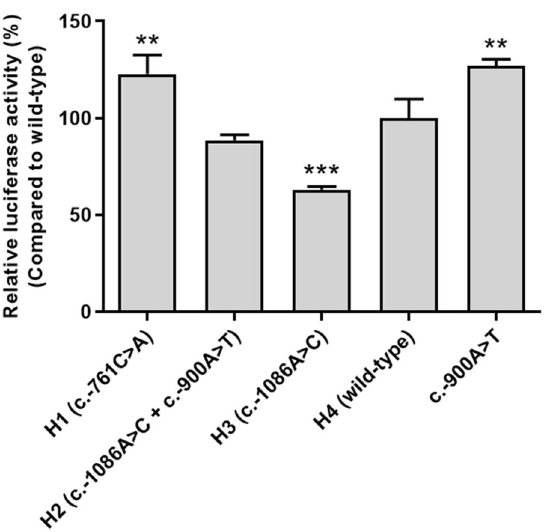
Figure 4. Effect of ABCA4 promoter variants on luciferase activity. Luciferase activity was measured after transfection of wild-type ABCA4 reporter plasmid or reporter plasmids containing ABCA4 variants into HCT-116 cells. The luciferase activity of each variant was compared with that of wild-type ABCA4 . The data (mean ± SD) represent triplicate measurements from a representative experiment. ** P < 0.01, *** P < 0.001 versus